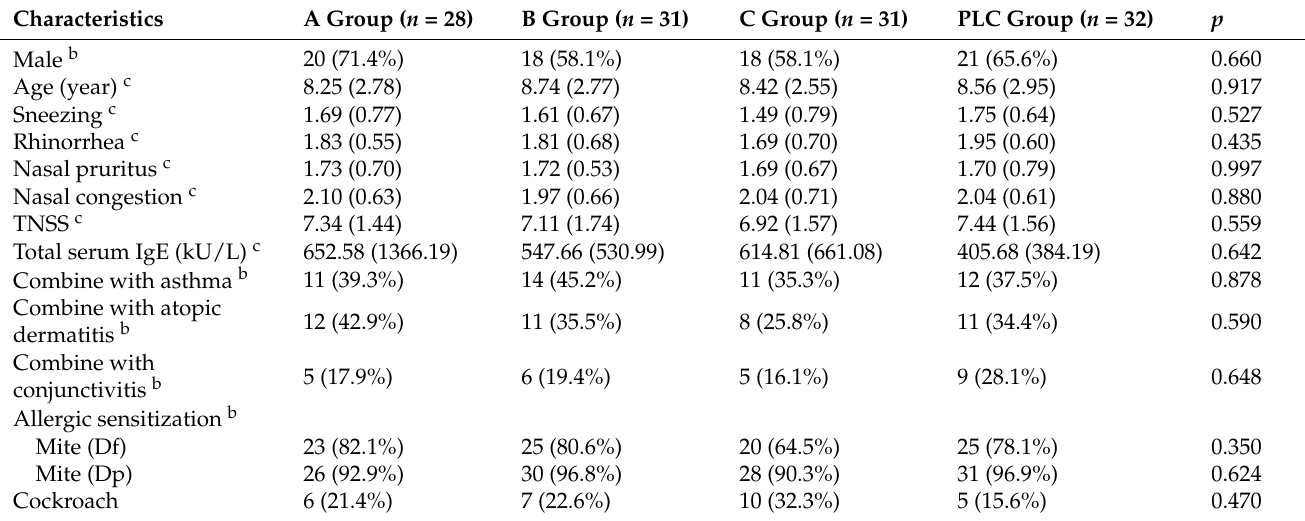
Figure 4. Effects of oral GM-080 on respiratory resistance in our OVA-induced AHR mouse model. ( A ) Illustration of the experimental procedure used for induction of OVA-induced AHR mouse model. Two dosages of GM-080 (LP-L, 2 × 10 6 CFU/mouse/day; LP-H, 1 × 10 7 CFU/mouse/day) were force-fed to mice through gavage. ( B ) Respiratory resistance was evaluated on the basis of Penh values under the inhalation of the indicated concentration of methacholine. NC, nontreated control; H 2 O, H 2 O gavage. * p < 0.05 compared with the H 2 O group. Table 3. Demographic and baseline characteristics of patients a